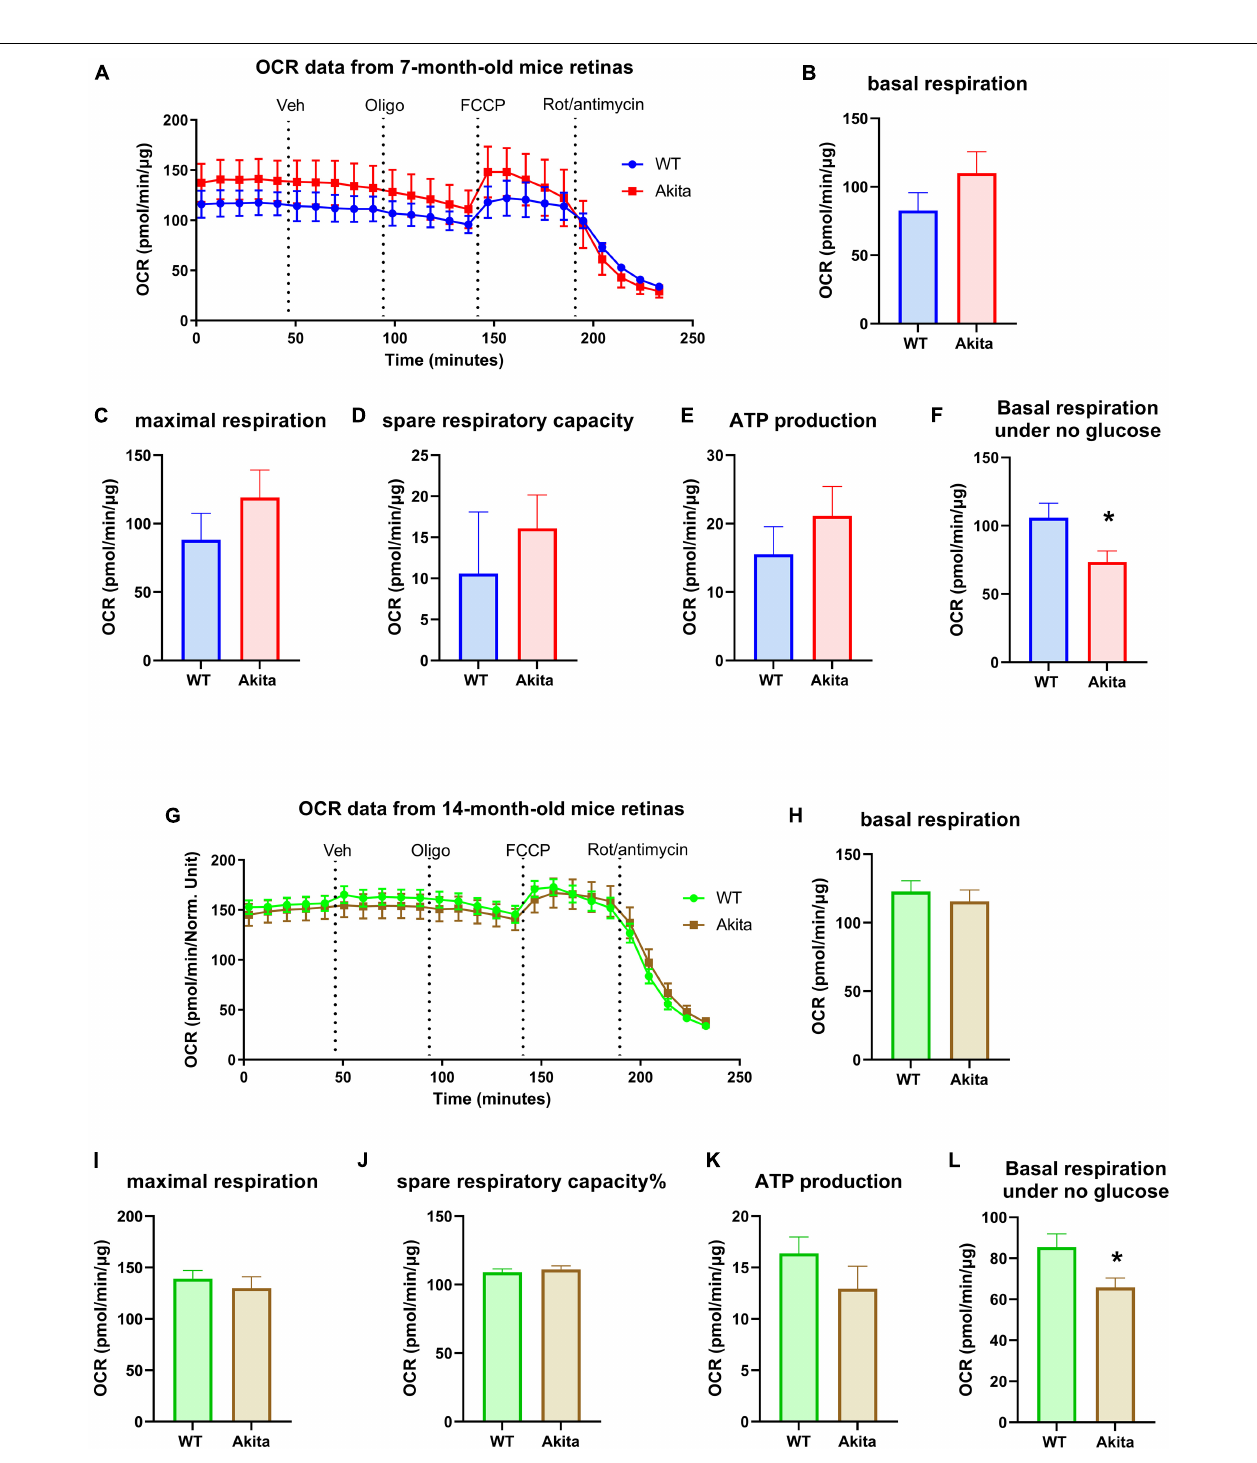
FIGURE 3 | Mitochondrial respiration of the Ins2 Akita diabetic retina. (A–E) Seahorse mitochondria stress test conducted by measuring the oxygen consumption rate (OCR) in retinal explants from 7-month-old mice shows no changes in basal respiration, maximal respiration, spare respiratory capacity and ATP production compared to control. N = 4. (G–K) Seahorse mitochondria stress test conducted by measuring the oxygen consumption rate (OCR) in retinal explants from 14-month-old mice shows no changes in basal respiration, maximal respiration, spare respiratory capacity and ATP production compared to control. N = 10–12. (F,L) Basal respiration calculated from the glycolysis assay analyses under no glucose conditions shows a reduction in basal OCR in the diabetic retinas from both 7- and 14-month-old Akita mice. * p < 0.05 vs. WT. N = 11.